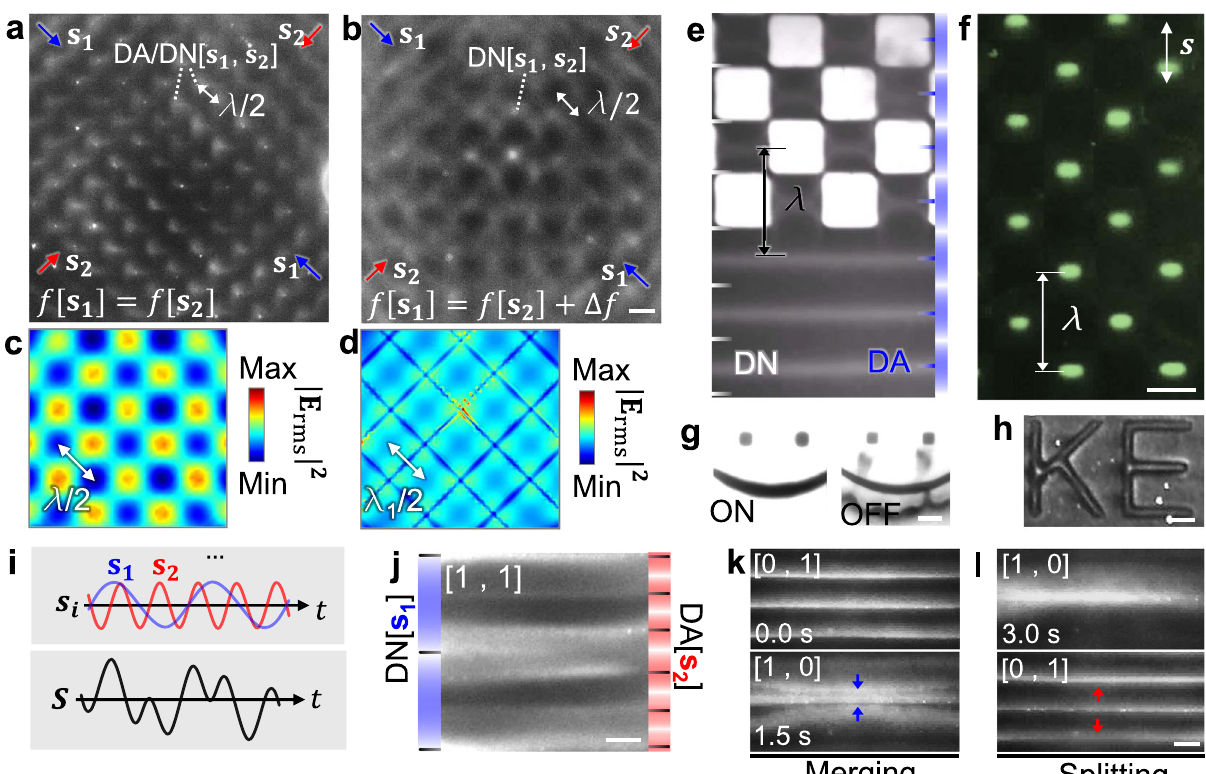
Fig. 4 Dynamic electric fi eld control via wave superposition. a Creating a 2D dot array of 100 nm polystyrene beads using orthogonal standing waves with identical frequencies ( f [ s 1 ] = f [ s 2 ]). b The dot array pattern transforms to network with a mesh-like electric fi eld distribution when f [ s 1 ] ≠ f [ s 2 ]. Numerically simulated magnitude of time-averaged electric fi eld strength ( E rms